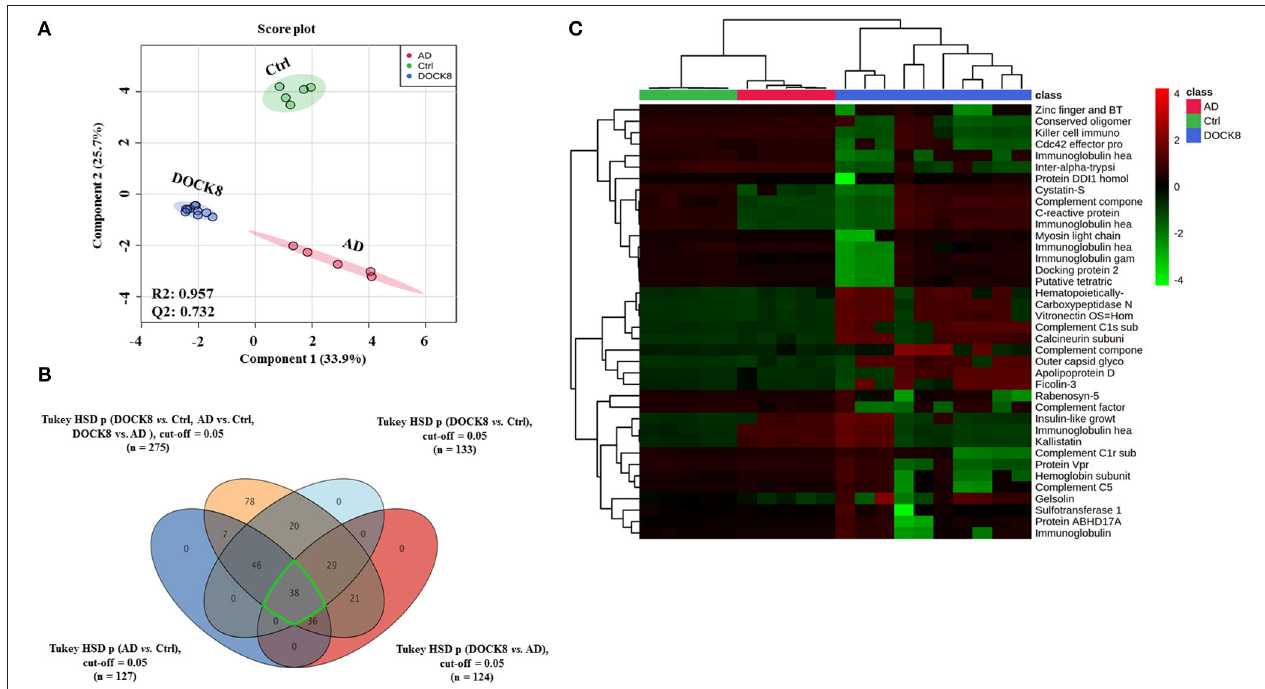
FIGURE 1 | Positively identified proteins in patients with dedicator of cytokinesis 8 (DOCK8) deficiency vs. AD vs. Ctrls. (A) PLS-DA score plot between patients with DOCK8 deficiency, patients with AD, and Ctrls ( R 2 = 0.957, Q 2 = 0.732, p < 0.001 for 100 permutations). (B) A Venn diagram shows the overlap between the statistically significant proteins in each binary comparison based on one-way ANOVA (Tukey’s post-hoc FDR p < 0.05). Out of 275 differentially regulated proteins, 133 were statistically significant between DOCK8 and Ctrl, 127 between AD and Ctrl, and 124 between DOCK8 and AD. (C) A heat map for the 38 commonly differentially regulated proteins among the study binary